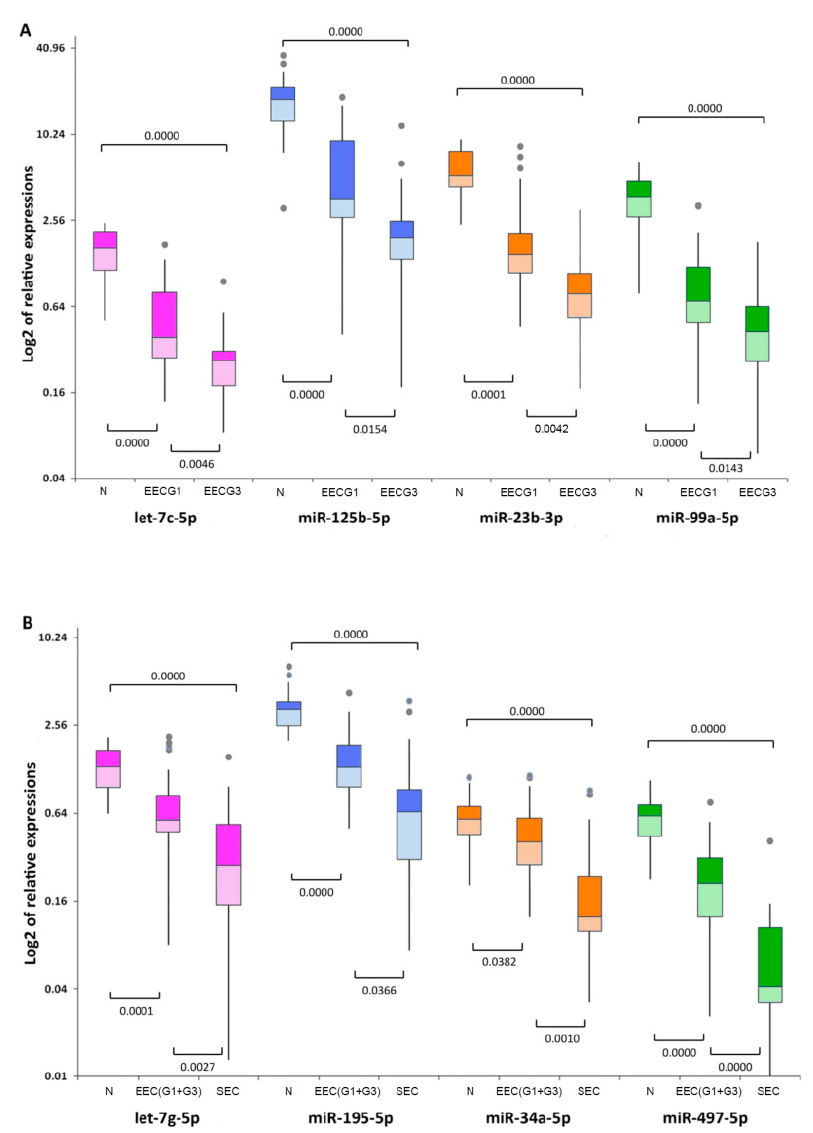
Figure 2. Relative expression of differentially expressed miRNAs. Differential expression of let-7c-5p, miR-125b-5p, miR-23b-3p, and miR-99a-5p between grade 1 (EEC G1) and grade 3 (EEC G3) endometrioid endometrial carcinoma compared with the non-neoplastic endometrium (N) ( A ), and differential expression of let-7g-5p, miR-195-5p, miR-34a-5p, and miR-497-5p between endometrioid endometrial carcinoma (EEC(G1 + G3)) and serous endometrial carcinoma (SEC) compared with the non-neoplastic endometrium (N) ( B ). Box lengths correspond to the interquartile range (IQR) and represent values between 75th and 25th percentiles. Values greater than 1.5 IQRs from the end of the box are labeled as outliers (grey points). Horizontal lines depict the medians. Statistical significance was considered at p < 0.05.